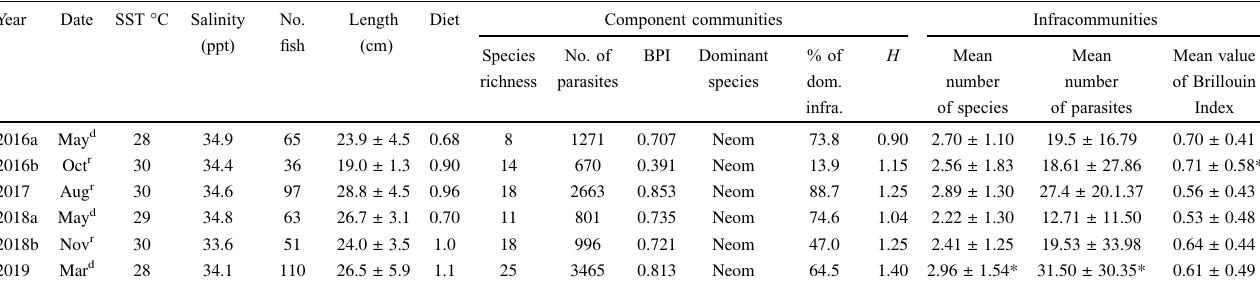
Table 2. Characteristics of the parasite component communities and infracommunities of Caranx sexfasciatus from Acapulco Bay, Mexico.